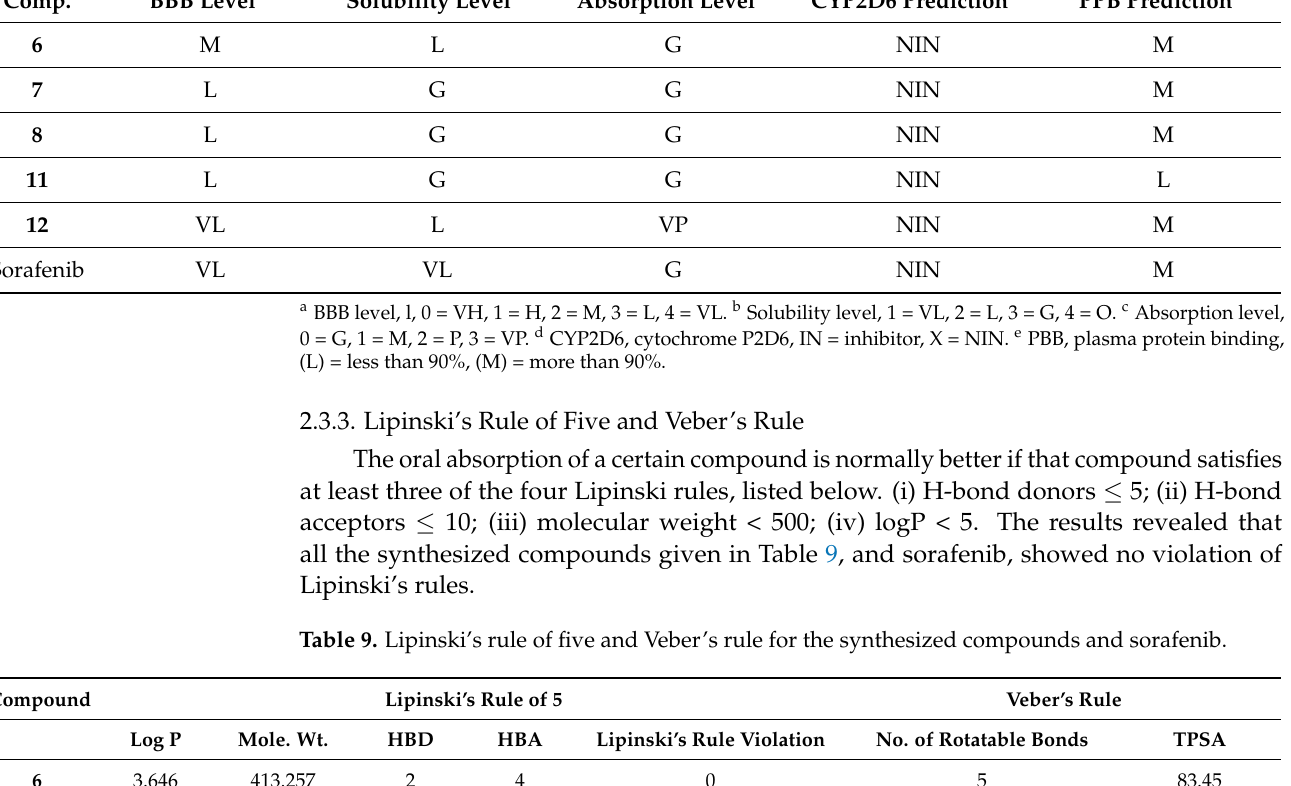
Table 8. In silico ADMET features of the considered compounds and sorafenib. Comp.